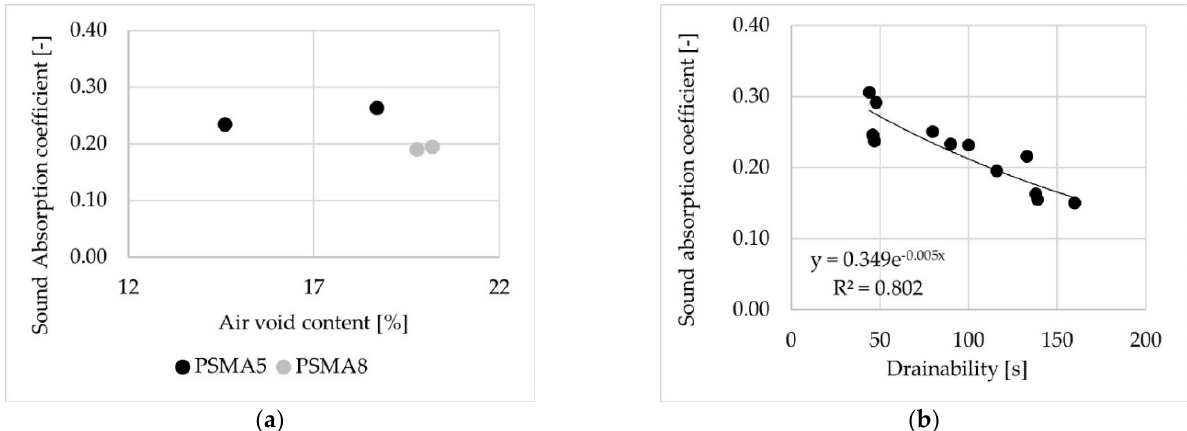
Figure 19. Sound absorption coefficient on the test sections, in relation to: ( a ) air void content, ( b ) water drainability.